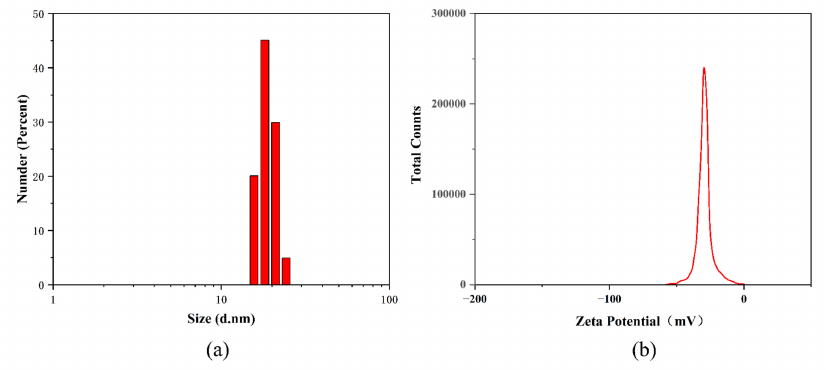
Figure 2. Particle size analysis ( a ) and Zeta potential ( b ) study of the